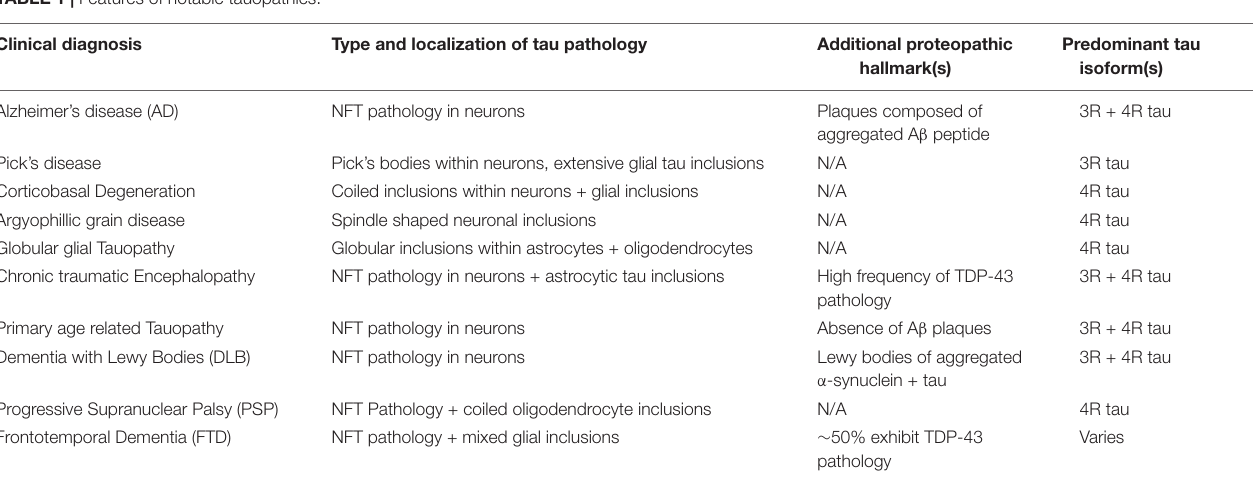
TABLE 1 | Features of notable